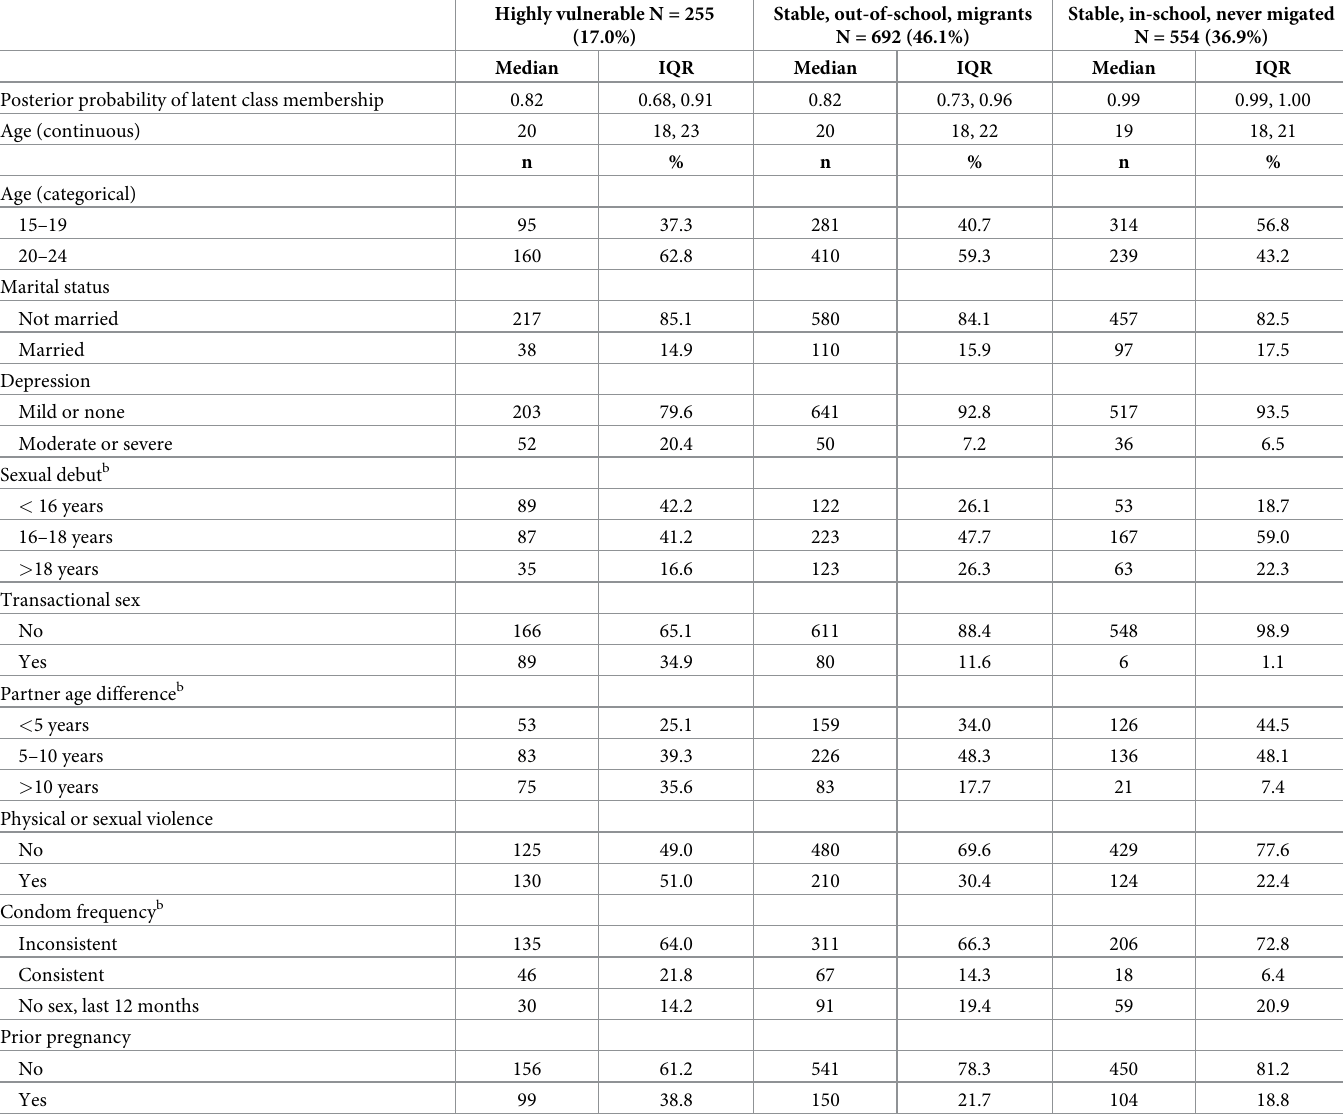
Table 3. Demographic, behavioral, and psychosocial characteristics by latent class analysis among 1,501 adolescent girls and young women aged 15–24 years in Ethiopia, 2018–2019 a .